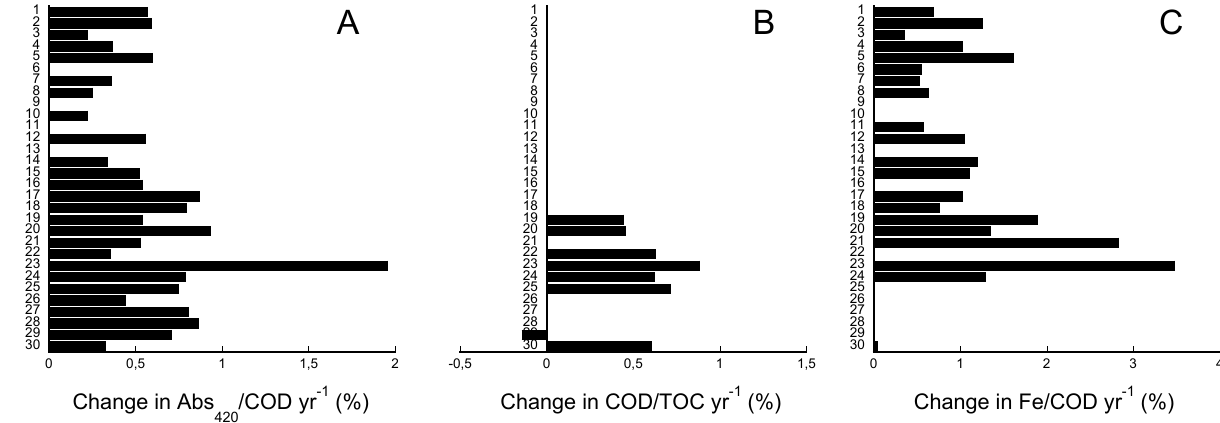
Fig. 5. The rate of change per year of Abs 420 /COD, COD/TOC and Fe/COD in all the rivers. For Abs 420 /COD and Fe/COD it is the change between 1972 and 2010. For COD/TOC it is the change between 1987 and 2010. Where there are no bars there is no significant change over